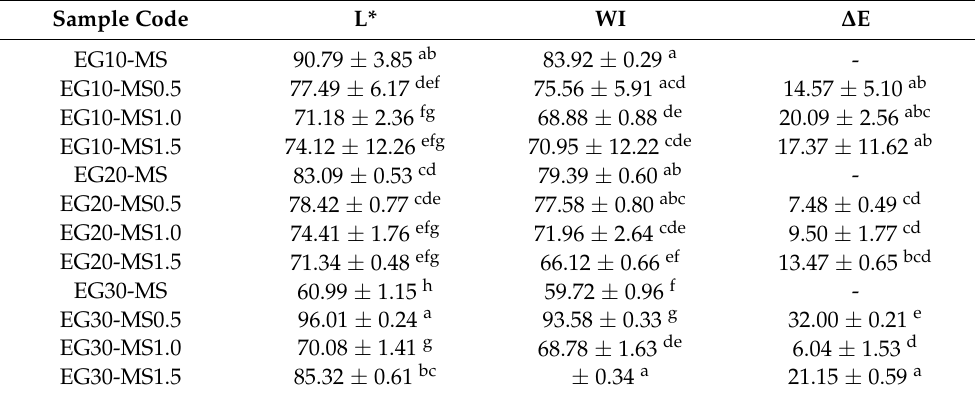
Table 2. Color parameters obtained for EG-m formulations of carboxymethylcellulose/mango starch emulsion gels with 1% w/w of mango peel extracts. L * , lightness; WI , whiteness index; ∆𝐸 , color variation.